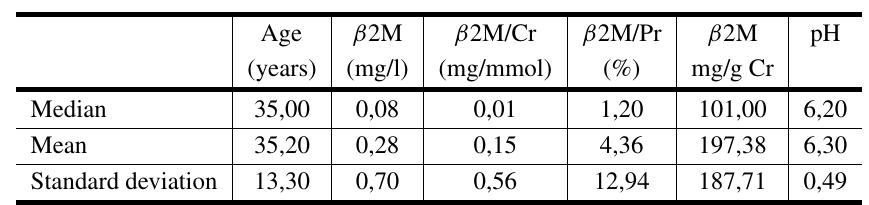
Results of β 2 -microglobulin ( β 2 M), total protein and pH In the first urine in the morning; n = 35 (23M/12F).